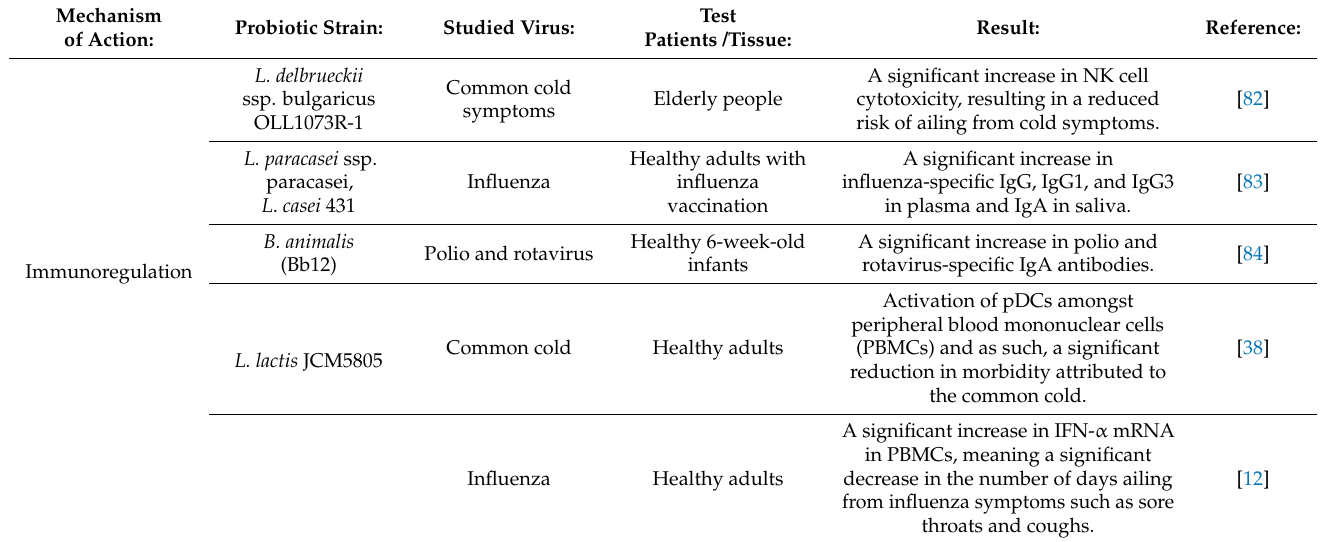
Table 2. Viral- and host-produced compounds modulated by immunobiotic